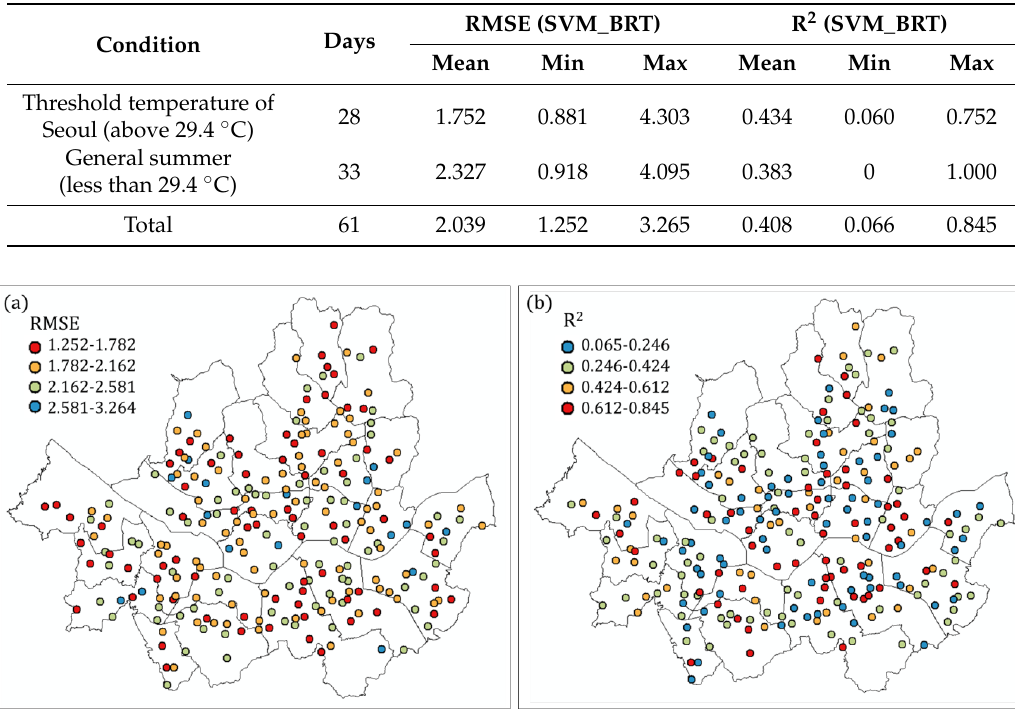
Table 5. Evaluation results according to SKT observation air temperature data.